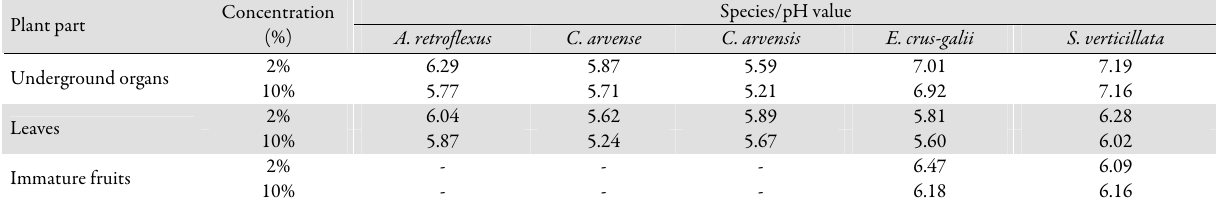
Note:* indicates significant differences (Tukey test, p<0.05); S - speed of germination; AS - the speed of accumulated germination; CRG - the coefficient of the rate of germination; LR - the length of root; LH - the length of hypocotyls; the number in brackets represent the percentage relative to the control. Table 3. The pH of the